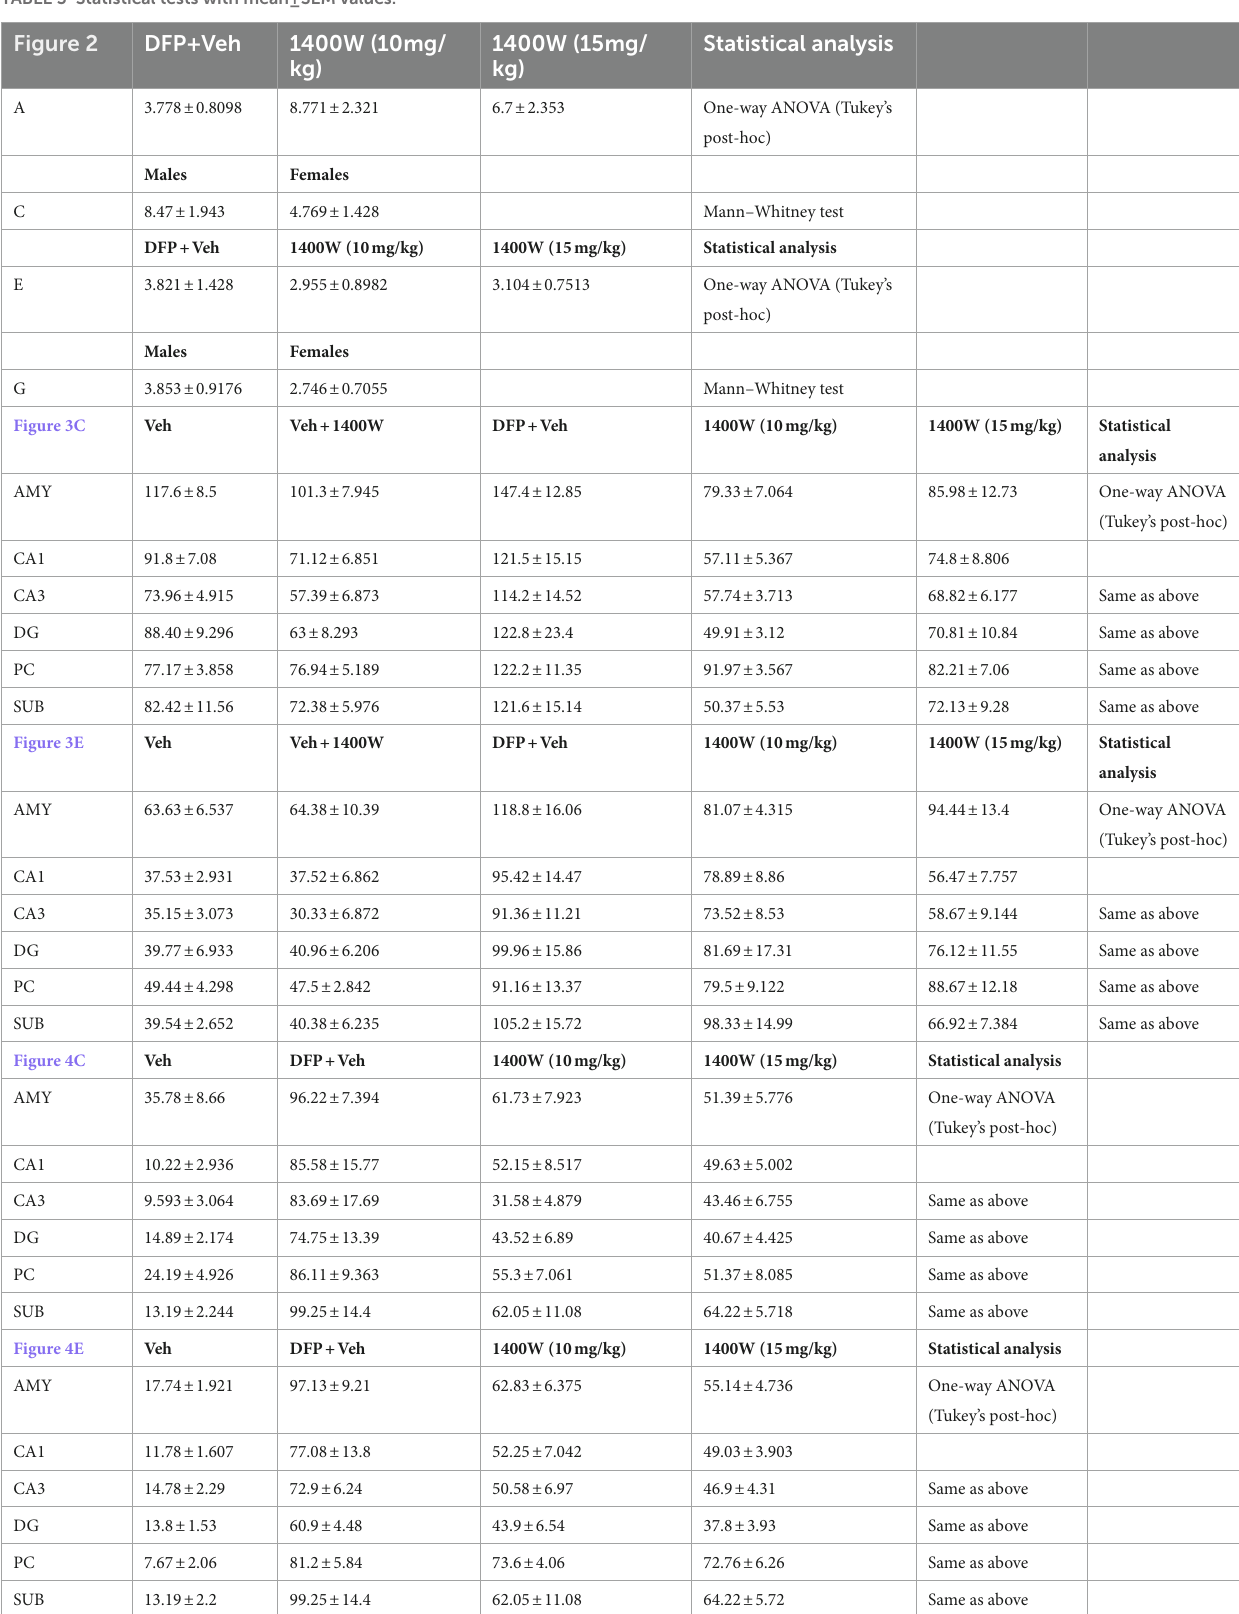
TABLE 3 Statistical tests with mean ± SEM